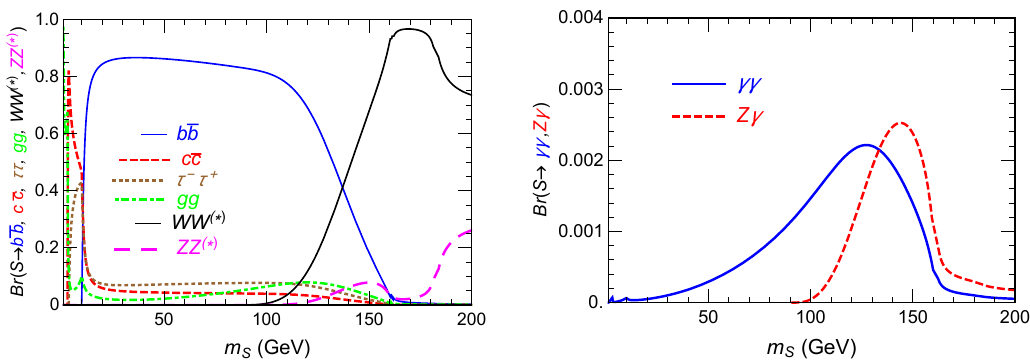
Figure 2 . The branching ratios (Brs) of the hidden scalar S with m S < 200 GeV. The dominant modes are shown in the left panel [17], while (cid:13)(cid:13) and Z(cid:13) modes are given in the right panel. The Brs are essentially independent of the value of (cid:11)